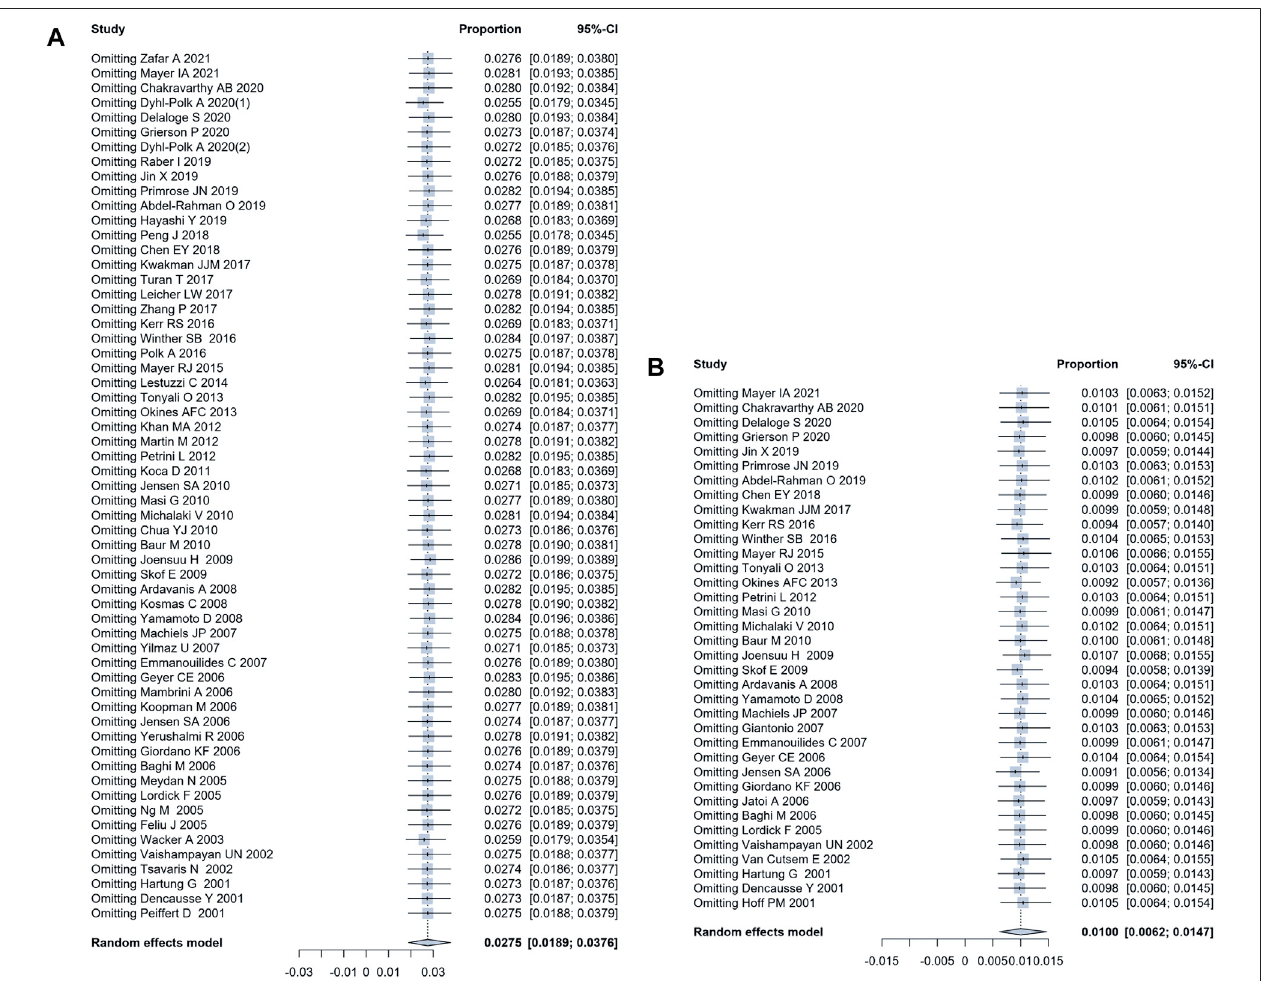
FIGURE 4 | The results of sensitive analysis. (A) the sensitive analysis of the incidence of all-grade coronary disorders indicated a variation between 2.64% and 2.86%; (B) the sensitive analysis of the incidence of grade 3 or higher coronary disorders indicated a variation between 0.92% and 1.07%.